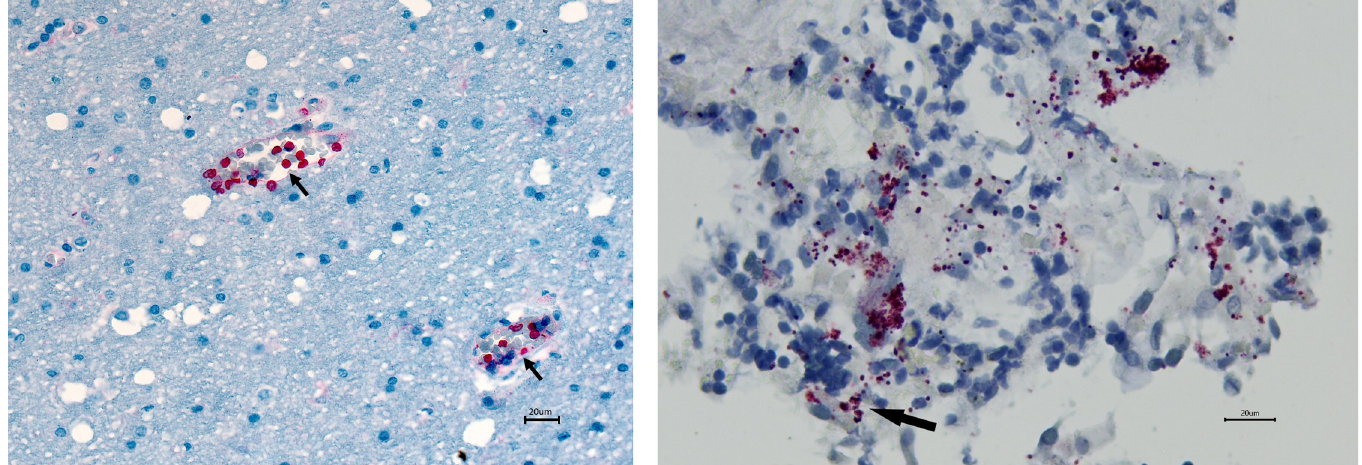
Fig 2. On the left, Plasmodium falciparum are visualized via staining by immunohistochemistry within red blood cells in small blood vessels (arrows) in the brain. On the right, clusters of Streptococcus pneumoniae bacteria are seen in the lung of the same child by immunohistochemistry (arrow pointing to one cluster).